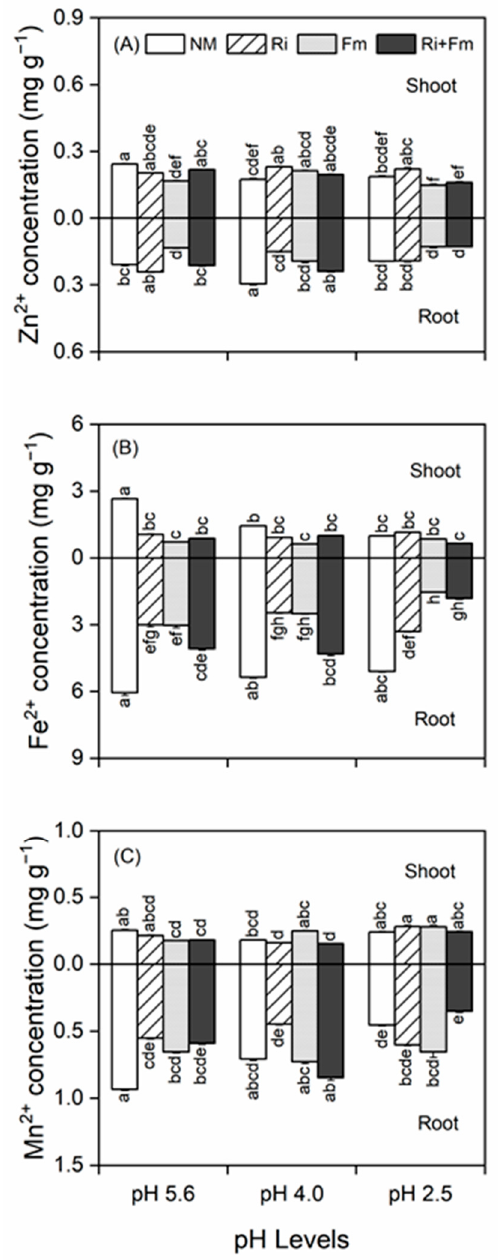
Figure 4. Effects of arbuscular mycorrhizal fungi on micronutrients of Zn 2+ ( A ), Fe 2+ ( B ), and Mn 2+ ( C ) in shoot and root of Torreya grandis under acid rain with pH 5.6, 4.0, and 2.5. NM, Ri, Fm, and Ri+Fm represent the four AMF treatments: inoculation with no mycorrhizal fungi, with Rhizophagus irregularis, with Funneliformis mosseae , and with the combination of the two fungi inoculum, respectively. Values are presented as the mean ± SE ( n = 3). Different letters indicate a significant difference ( p <